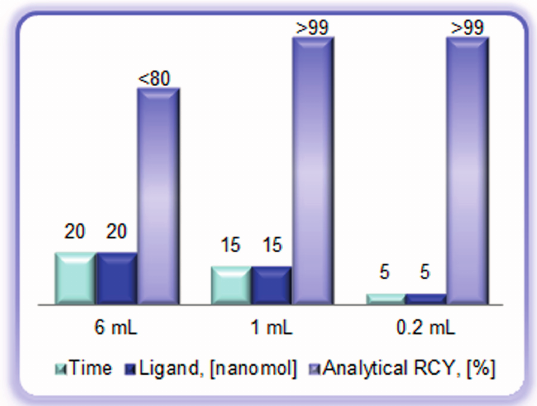
pre-concentrated/pre-purified generator eluate (0.2 mL, anion exchange